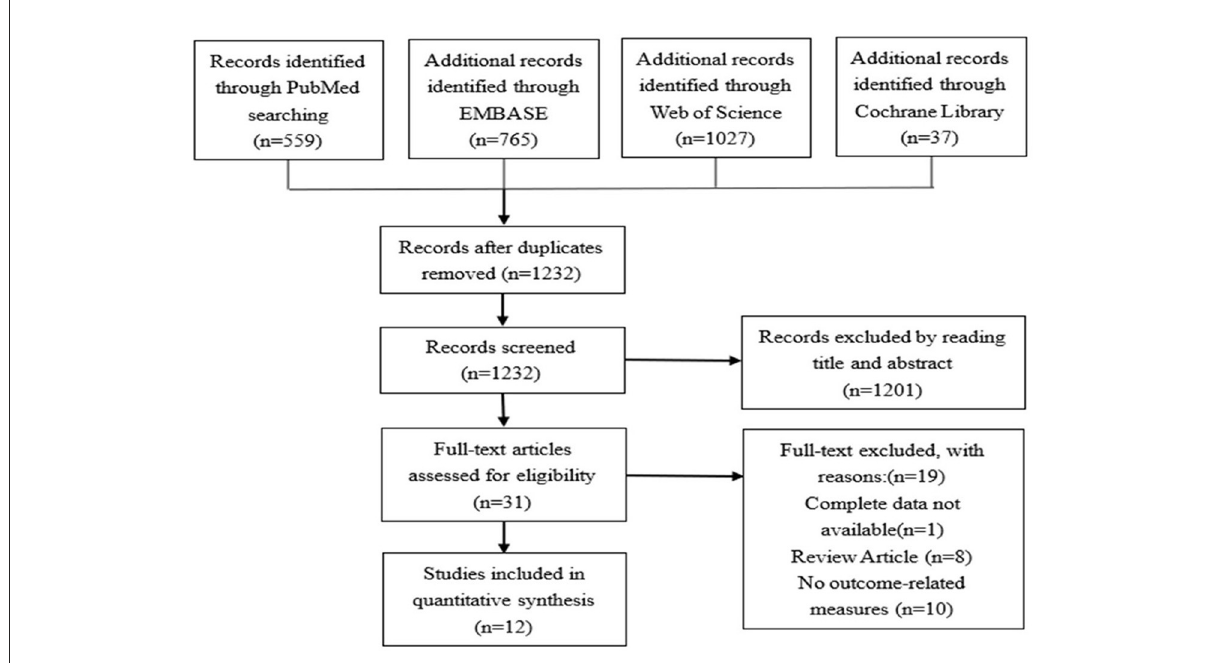
FIGURE1 Literature search and screening